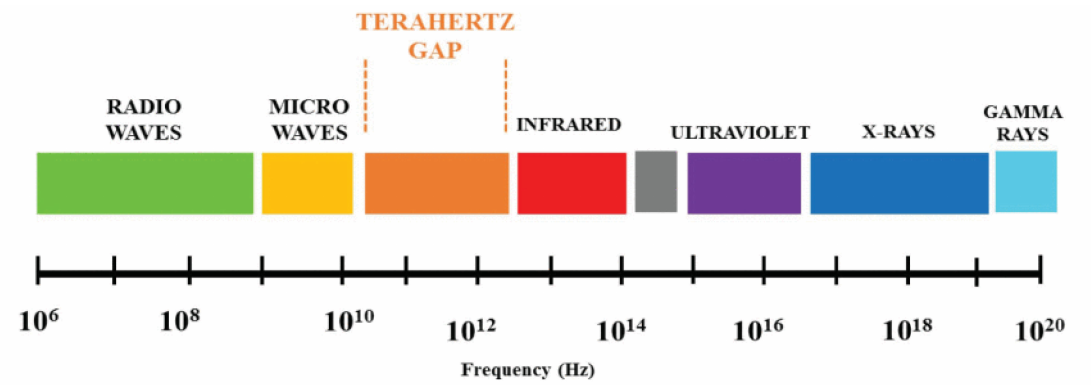
Figure 3. Terahertz gap in the electromagnetic spectrum